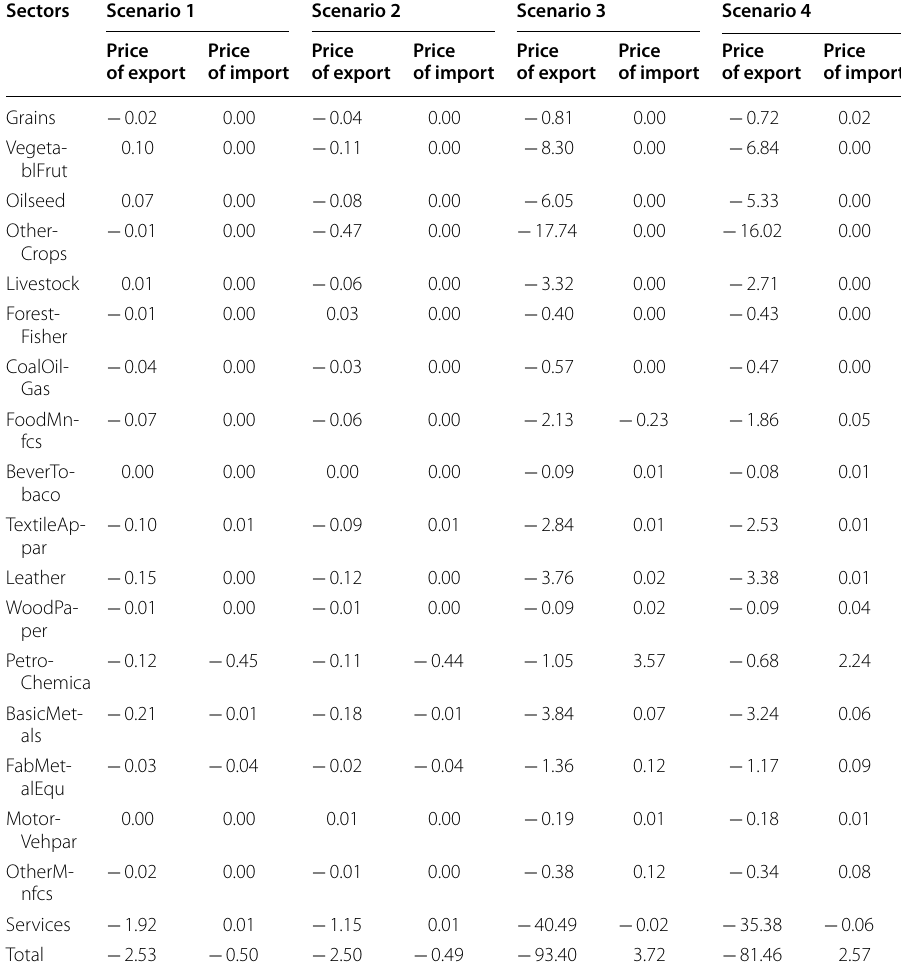
Table 9 Decomposition of terms of trade effect for Ethiopia, by commodity (US$